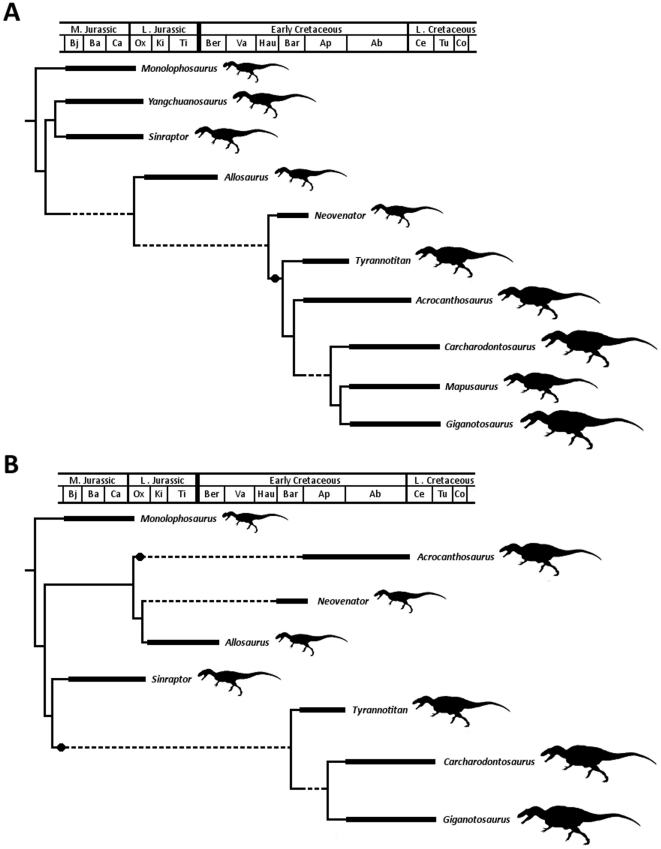
Phylograms and comparisons of body size optimization across
Allosauroidea.Constructed from the trees recovered by (A) EAC, the present analysis,
and (B) SET, Smith et al. [13]. Silhouettes are to
scale according to measurements listed in Table 6.